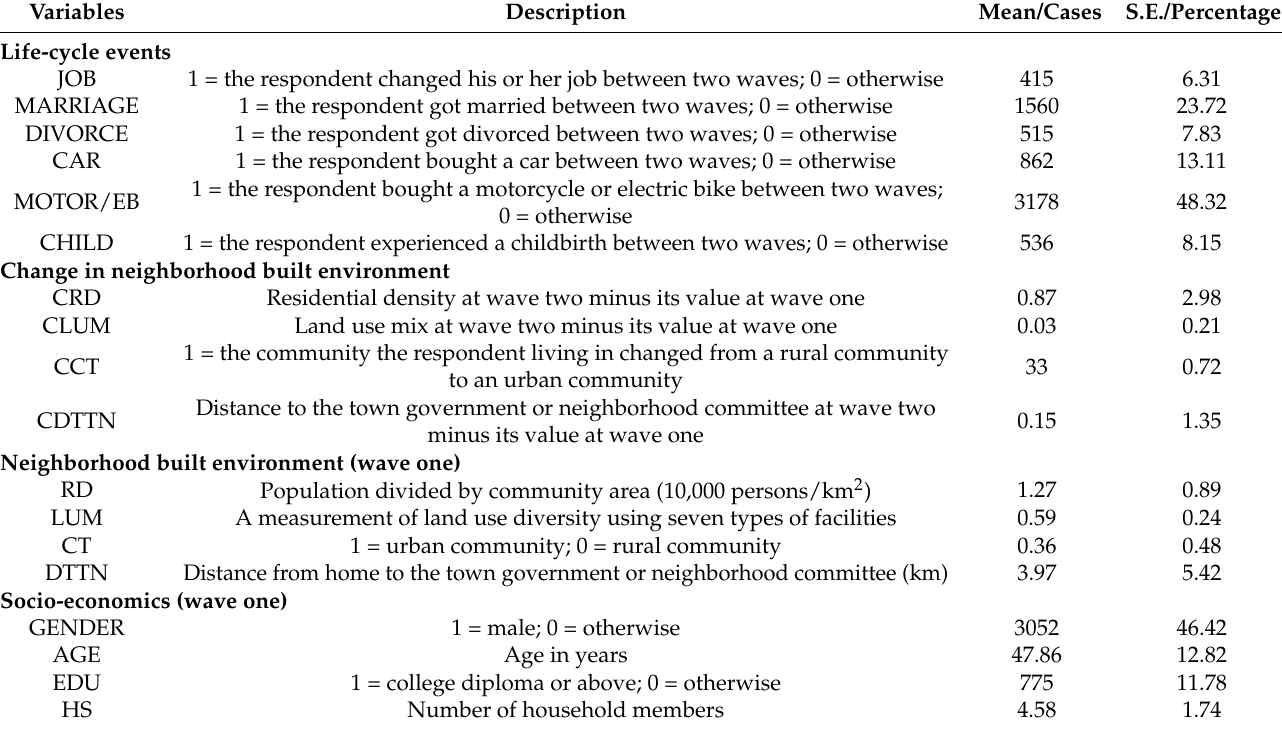
Table 2. Variables used for this